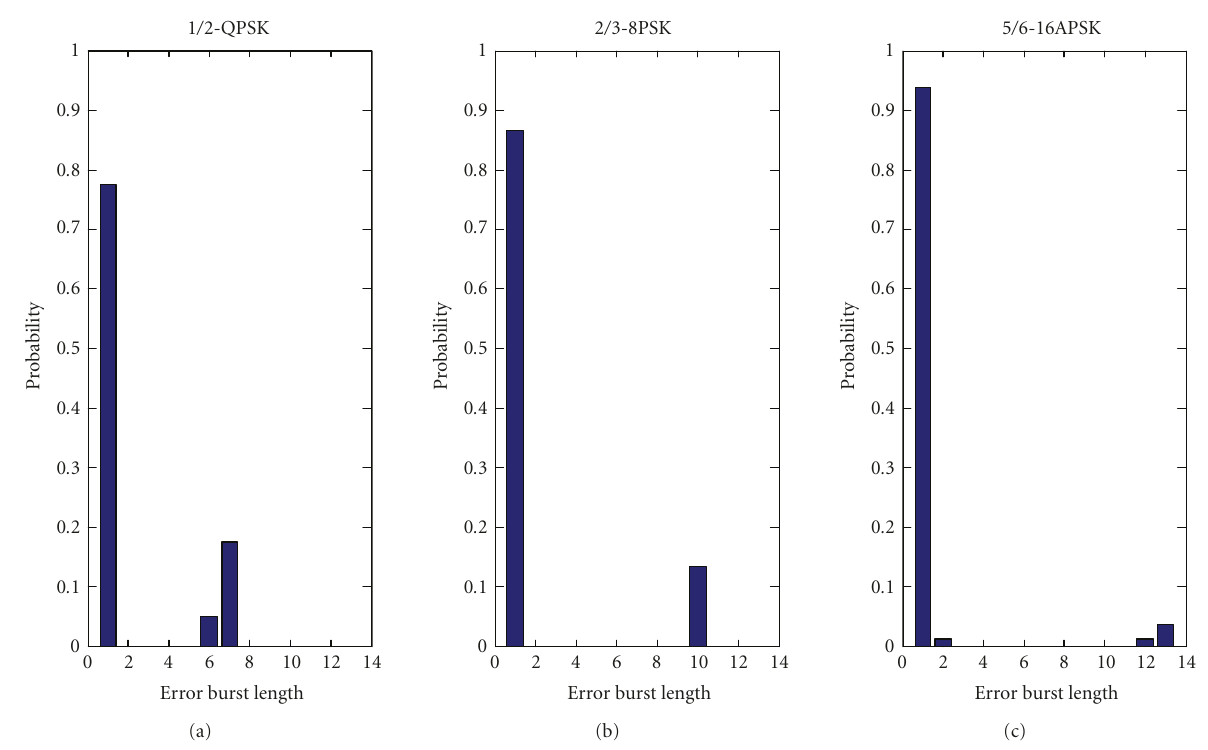
Figure 11: Histogram of the BBFRAME error burst length for two di ff erent MODCOD modes and target BBFRAME error rate equal to